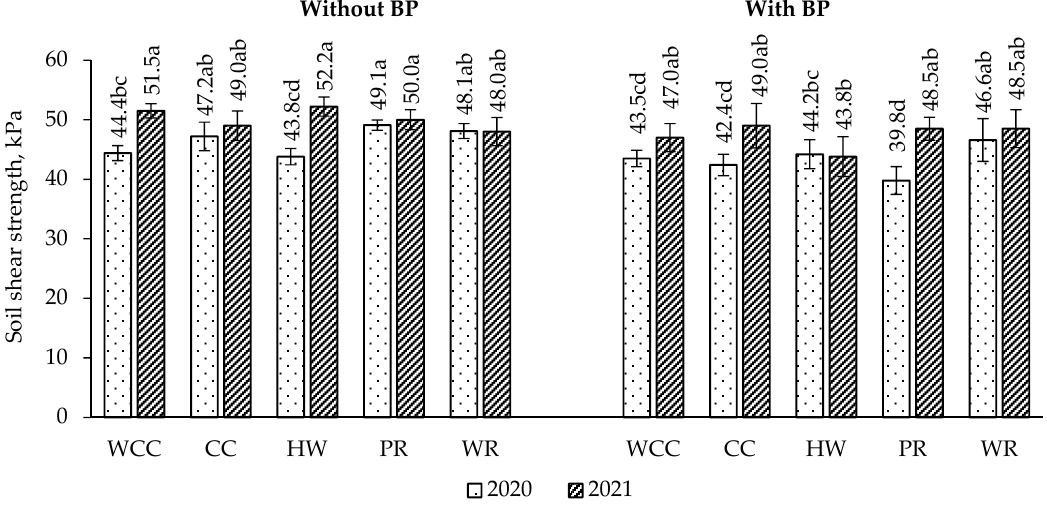
Figure 3. Soil shear strength. Note. BP—biopesticides (Factor A). Undersown cover crops (Factor B): WCC—without cover crop, CC—crimson (incarnate) clover, HV—hairy (winter) vetch, PR—perennial ryegrass, WR—winter rye. Differences between the averages of treatments marked with different letters (a, b, c, d) are significant ( p < 0.05); error bars indicate the standard error.